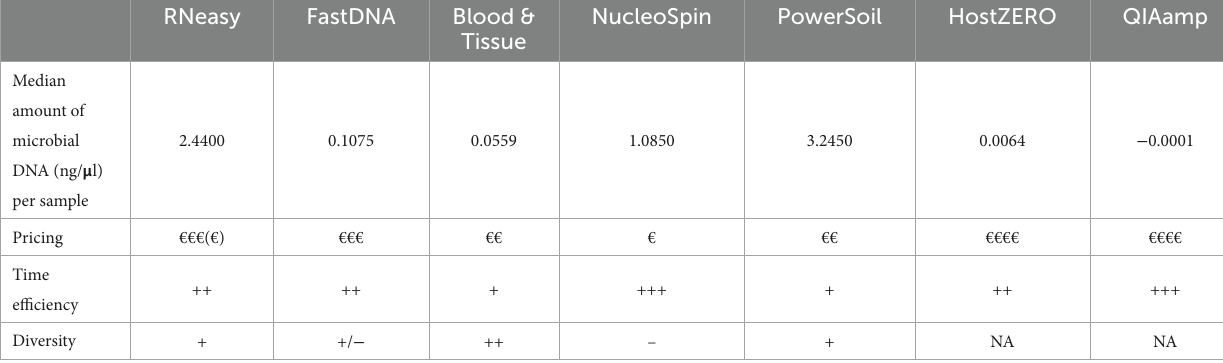
TABLE 3 Overview of the different DNA extraction kits concerning microbial DNA yield, pricing, time efficiency and diversity.